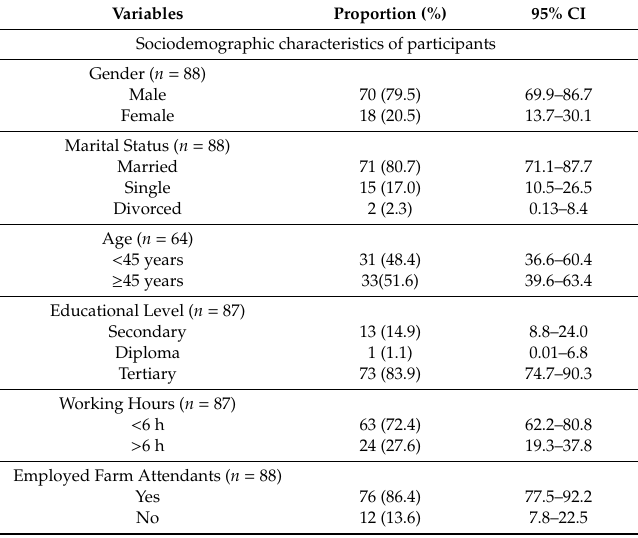
Table 1. Demographic profile of pig farmers in Ogun State, Nigeria.